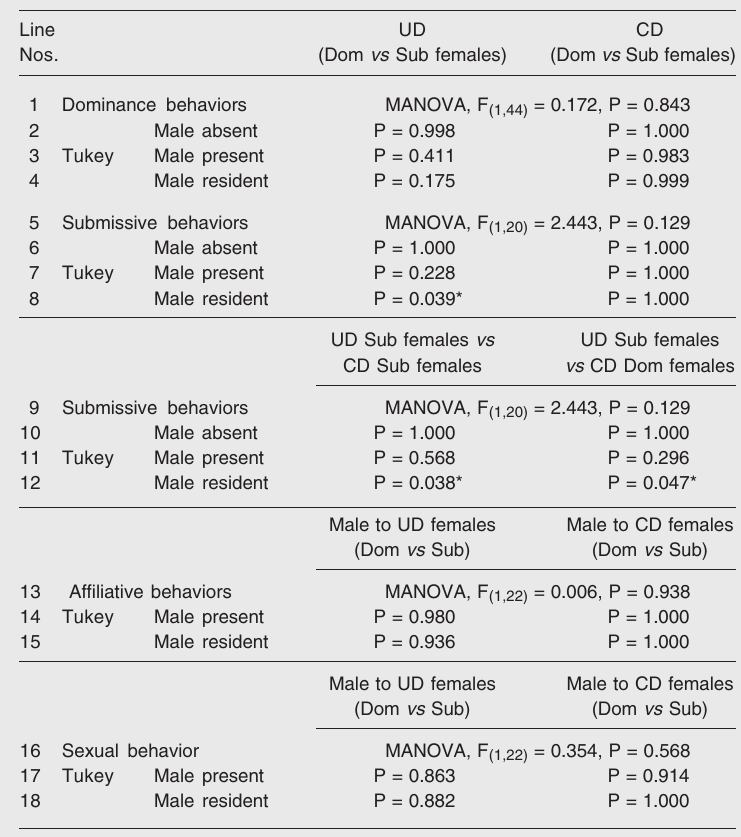
Table 3. Statistical analysis of dominant and submissive behaviors between females and affiliative and sexual behaviors from males to